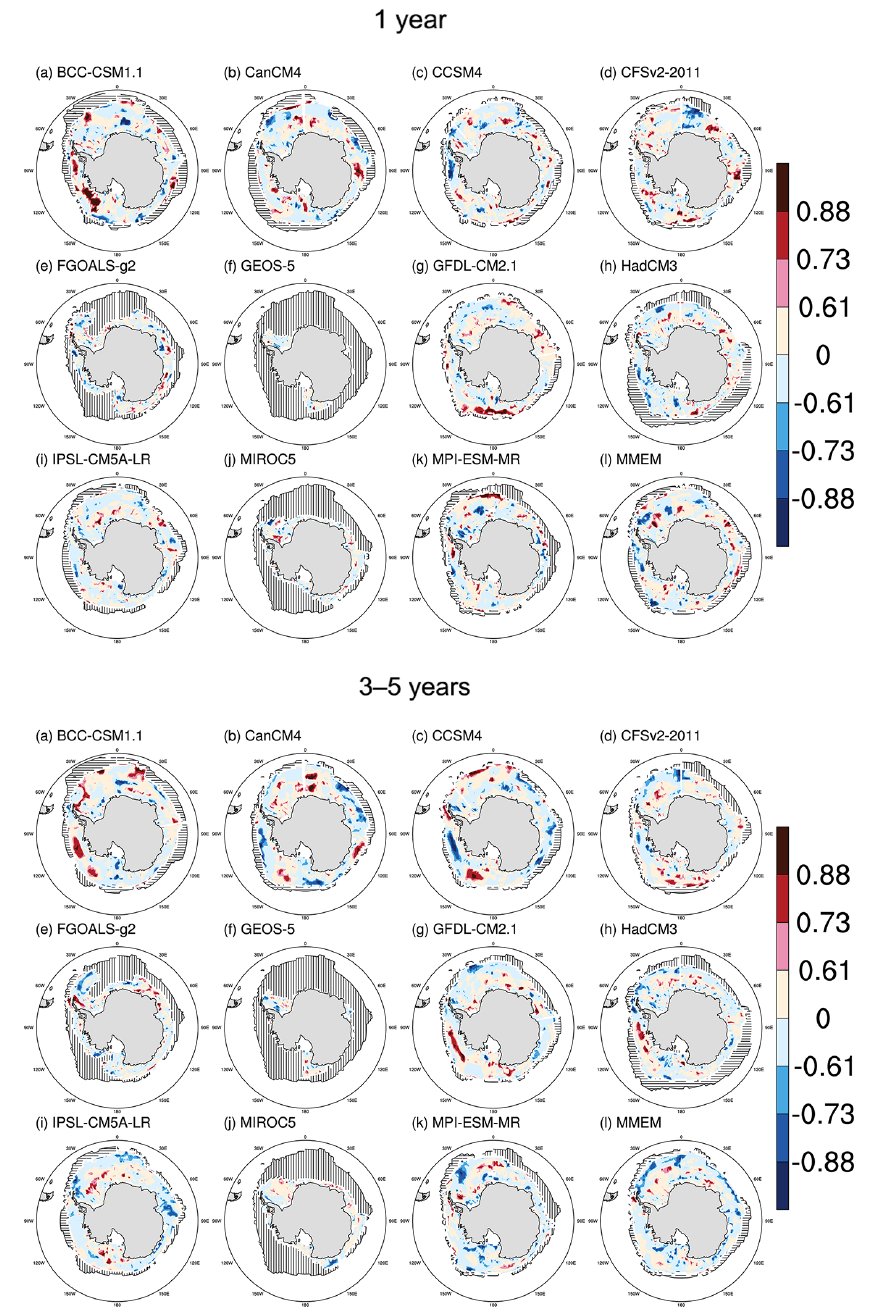
Figure 8. Anomaly correlation coefficients between the simulated and observed Antarctic September sea ice concentration anomalies for the lead time of 1 year (top panel) and 3–5 years (bottom panel). The correlation coefficients of 0.61, 0.73, and 0.88 represent 90, 95, and 99% confidence levels, respectively. Horizontal lines depict the areas where the model simulation has sea ice, whereas the observation does not have sea ice. The opposite is the case for vertical